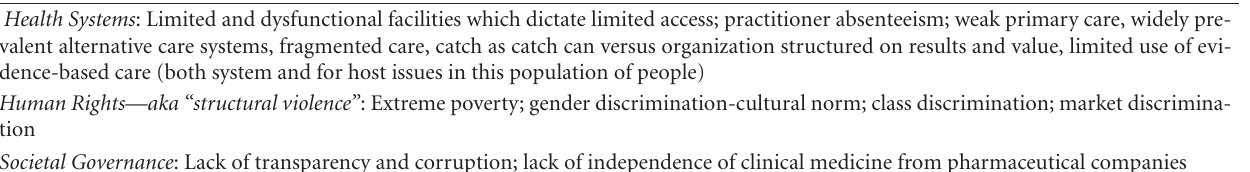
Table 4: Broad themes influencing outcomes from breast cancer in rural